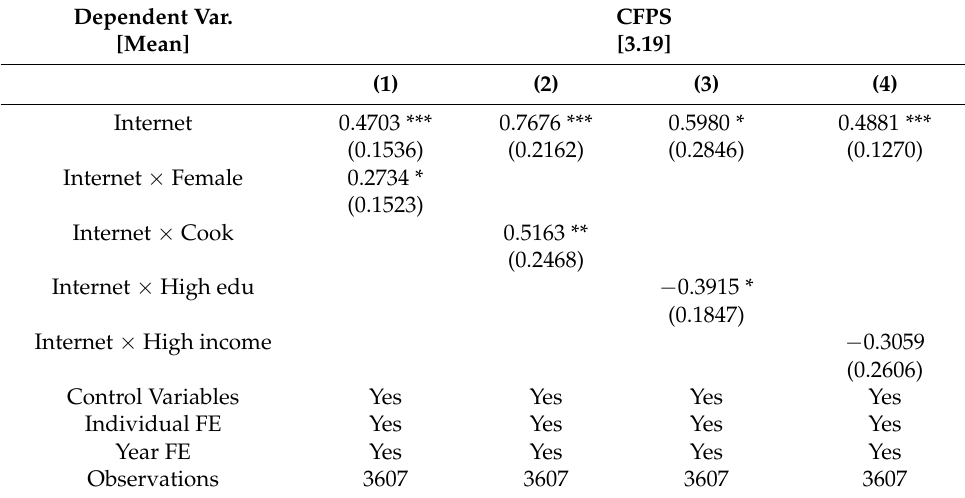
Table 6. Heterogeneous effects of Internet use on diet quality. Dependent